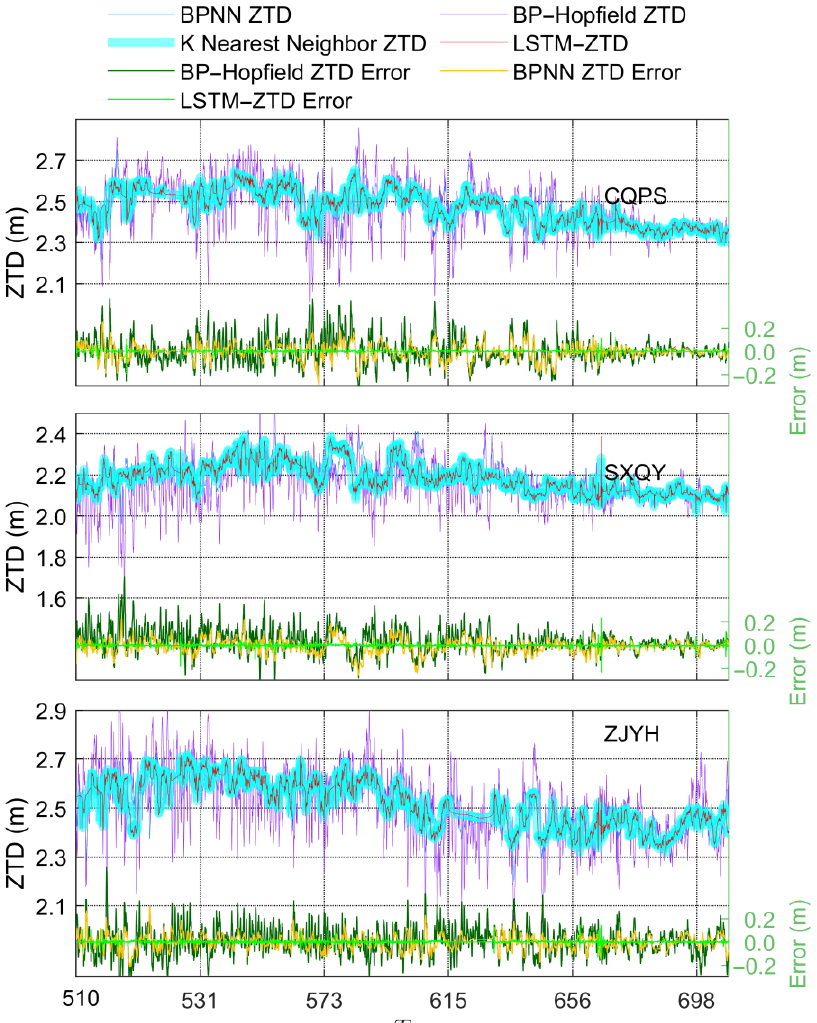
Figure 9. The ZTD series and their errors. Comparisons among different models. Each panel represents a station, where the blue, purple, cyan, and red curves show the BPNN, BP – Hopfield, KNN, and LSTM-ZTD models, respectively. The dark green, orange, and light green curves show the errors in the BP – Hopfield, BPNN, and LSTM-ZTD models, respectively.